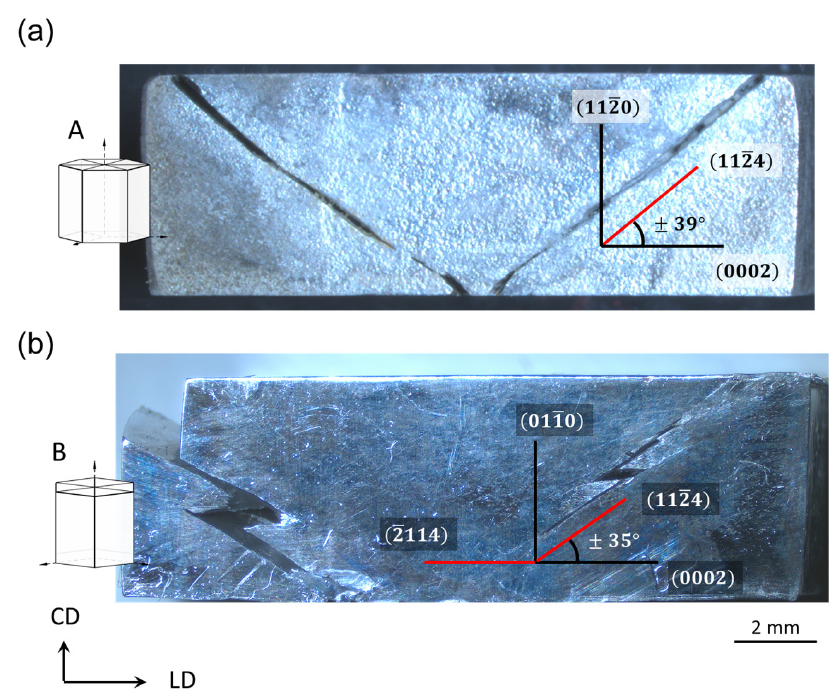
Figure 5. Optical micrographs of the CD ‐ LD plane of a specimen with ( a ) initial orientation A and ( b ) initial orientation B after fracture at room temperature.